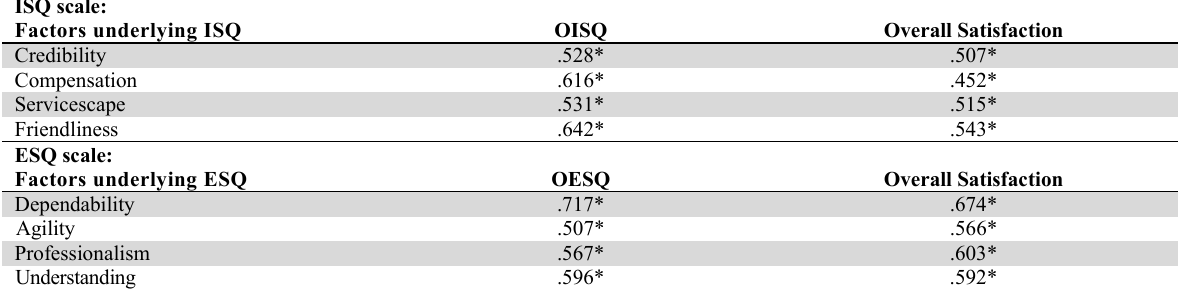
Correlation between factors of scales with Overall Service Quality and Satisfaction ISQ scale: Factors underlying ISQ OISQ Overall Satisfaction Credibility